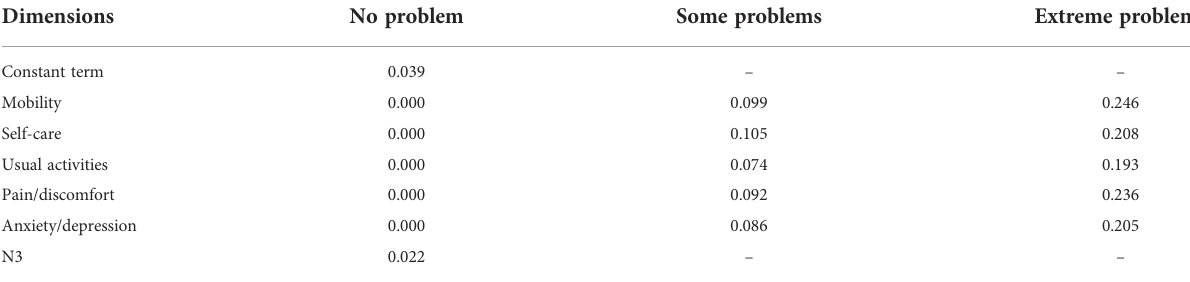
TABLE 1 EQ-5D-3L adopted the Time trade-off by Chinese